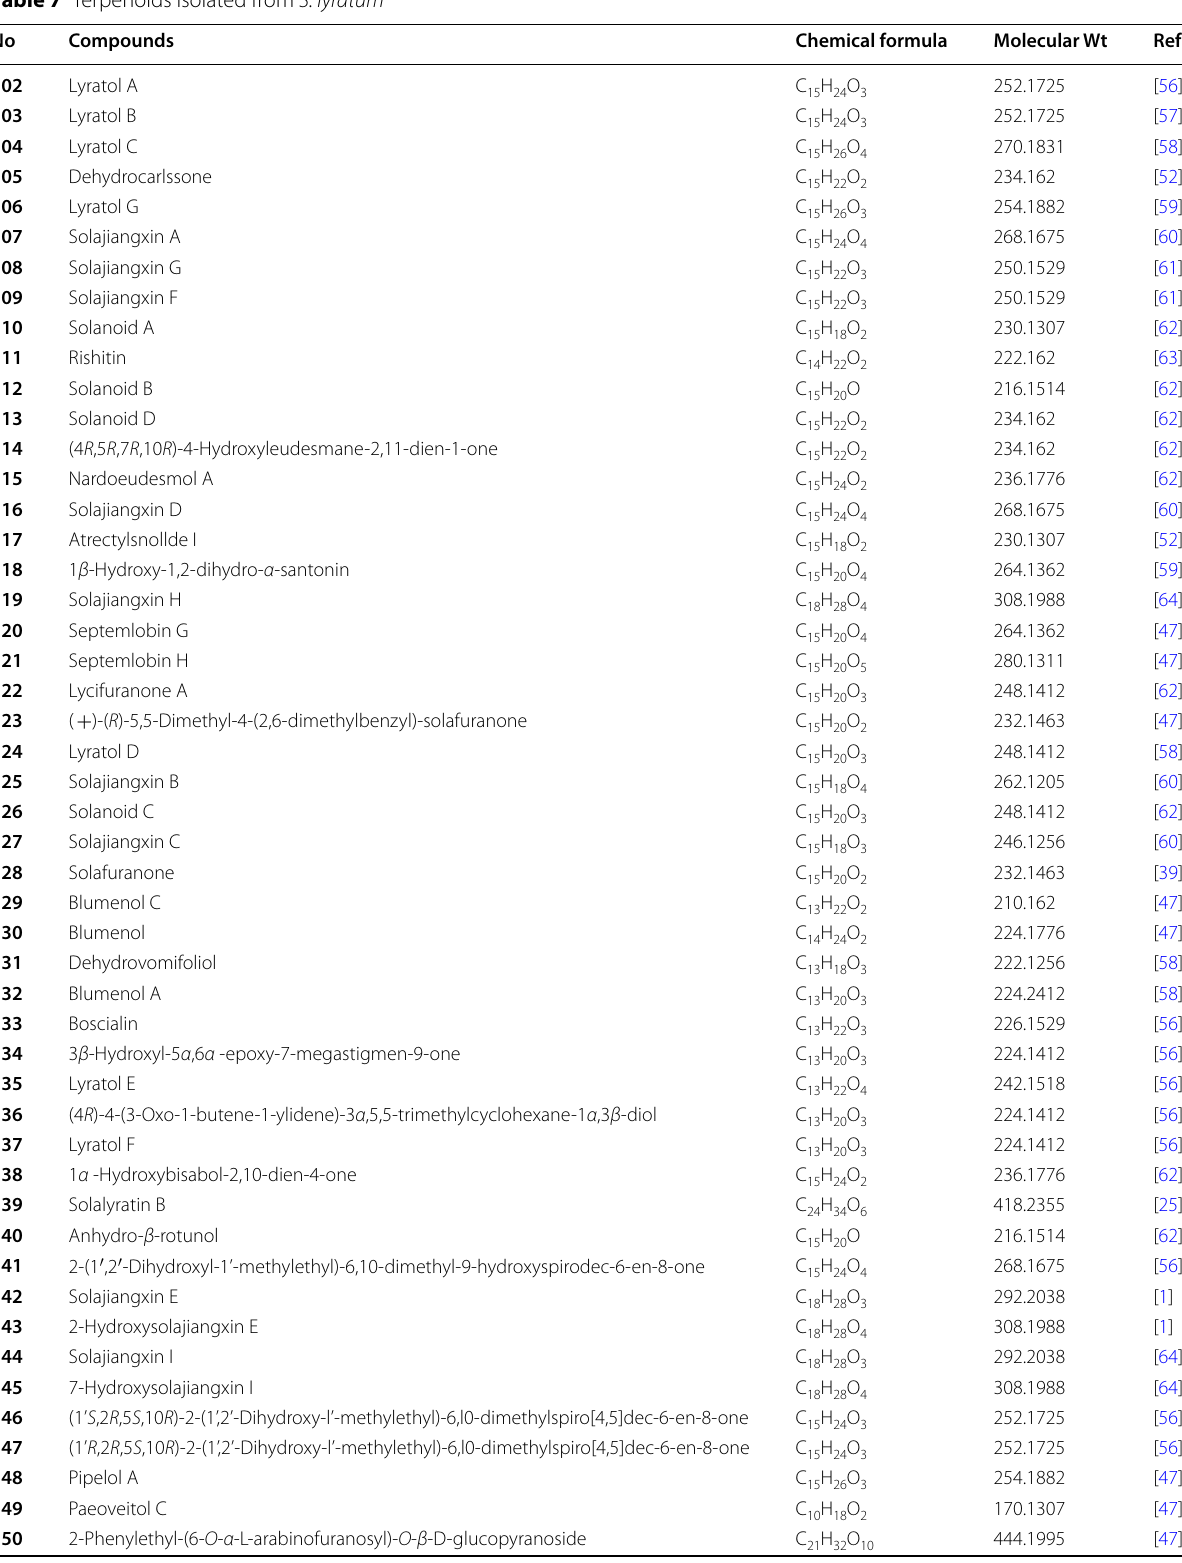
Table 7 Terpenoids isolated from S. lyratum No Compounds Chemical formula Molecular Wt